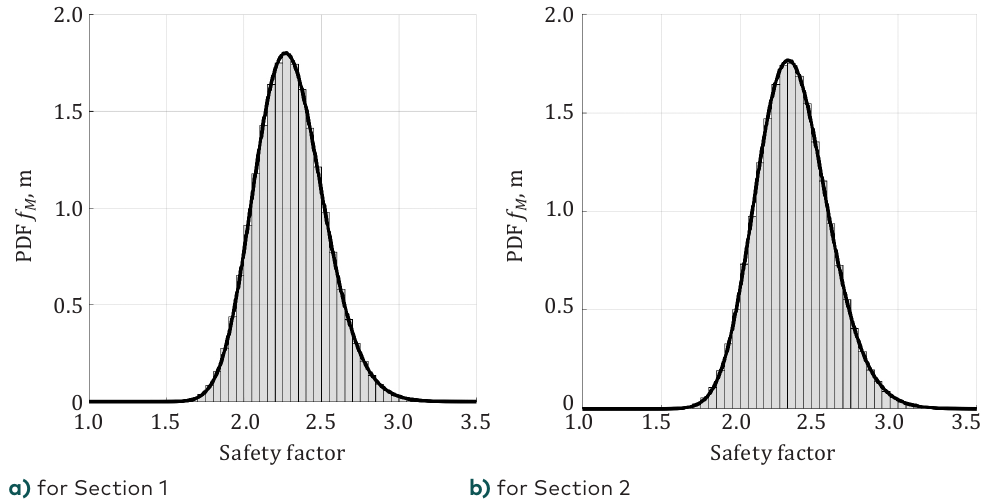
a) for Section 1 b) for Section 2 Safety Figure 9. Histogram and log-normal distribution of load multiplier